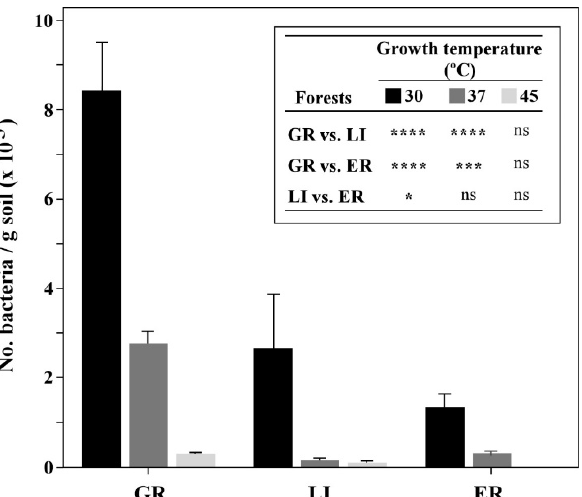
Figure 1. Titer of bacterial communities detected in each forest soil, according to bacterial growth temperatures used. Statistically significant differences are displayed on the side-table and significance levels are represented by * ( p ≤ 0.05), *** ( p ≤ 0.001) and **** ( p ≤ 0.0001); Non-significant differences are displayed with (ns).